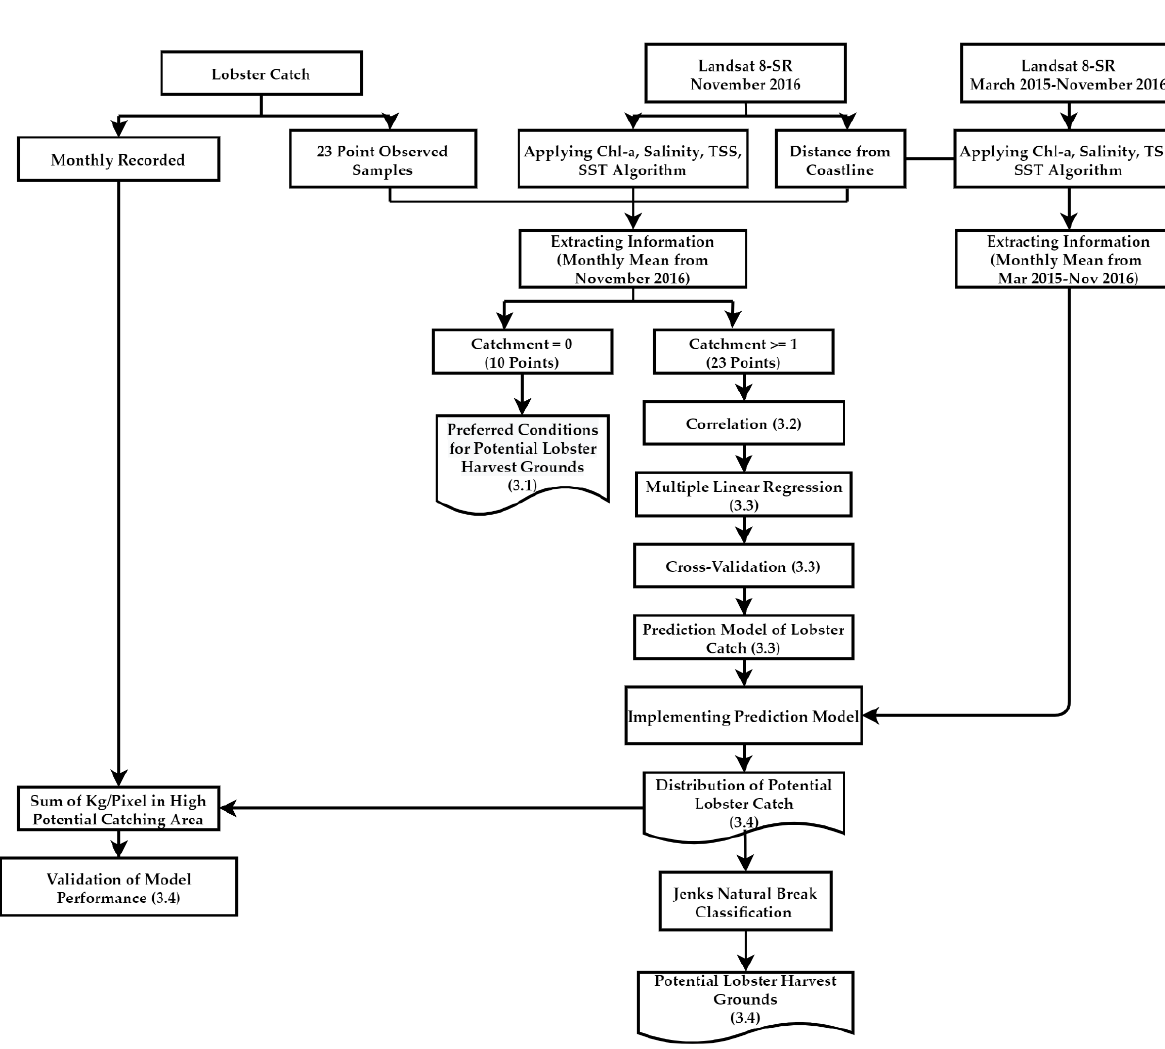
Figure 3. Research methodology.